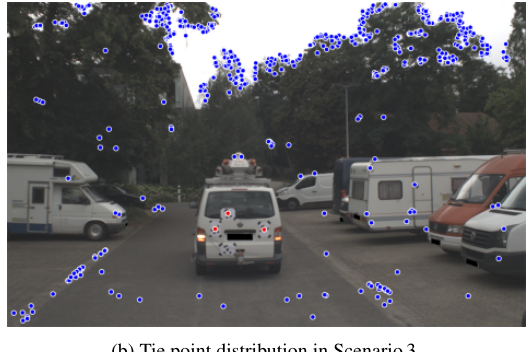
Figure 7. Example of tie point distribution in an image. Red: observed marker points. Blue: observed tie point.